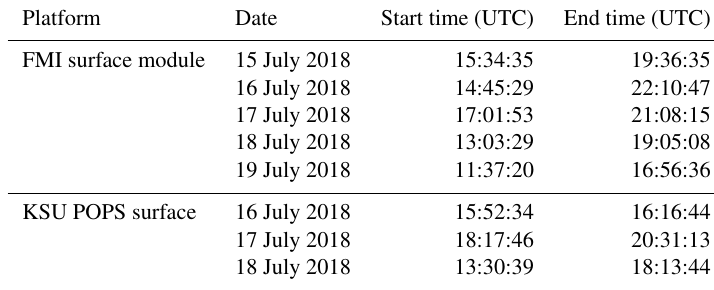
Table 3. Surface measurements at altitude 2291mm.s.l. – overview of platform and data